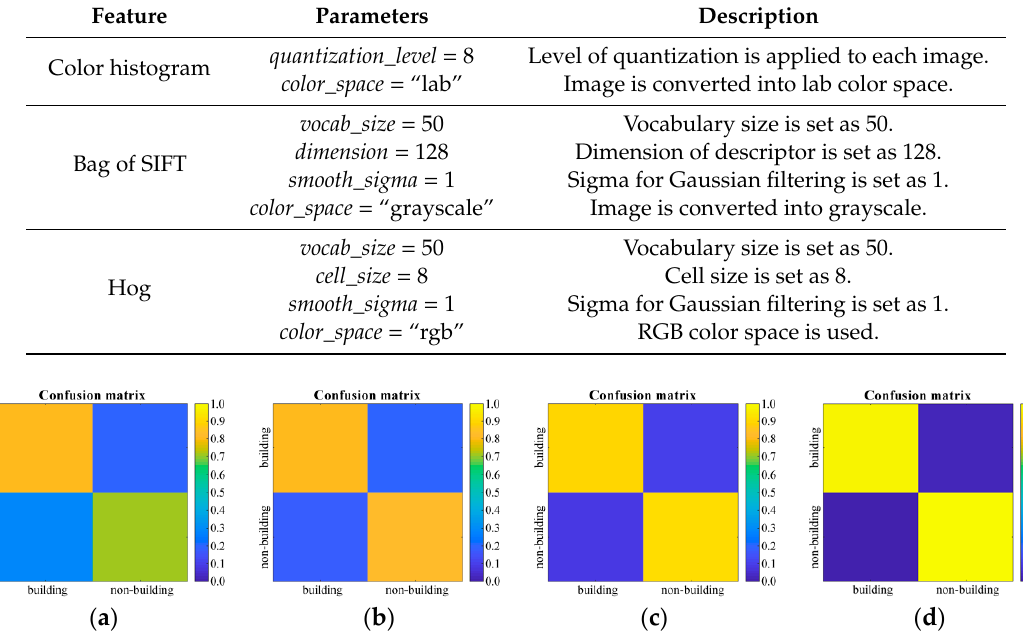
Figure 16. The experimental results of the ISPRS dataset using the proposed method. Red lines in ( a ), ( b ), ( d ), and ( e ) show the boundaries of superpixels obtained from the proposed 6D-SLIC algorithm. White regions in ( b ) and ( e ) are the vegetation obtained from the proposed GGLI algorithm. ( c ) and ( f ) are the buildings extracted by using the proposed framework, and white color denotes the building areas. Table 3. Parameters of Random Forest classifier. SIFT denotes the feature detected by using scale-invariant feature transform. Hog denotes the feature represented by using a feature descriptor, namely, histogram of oriented gradients.